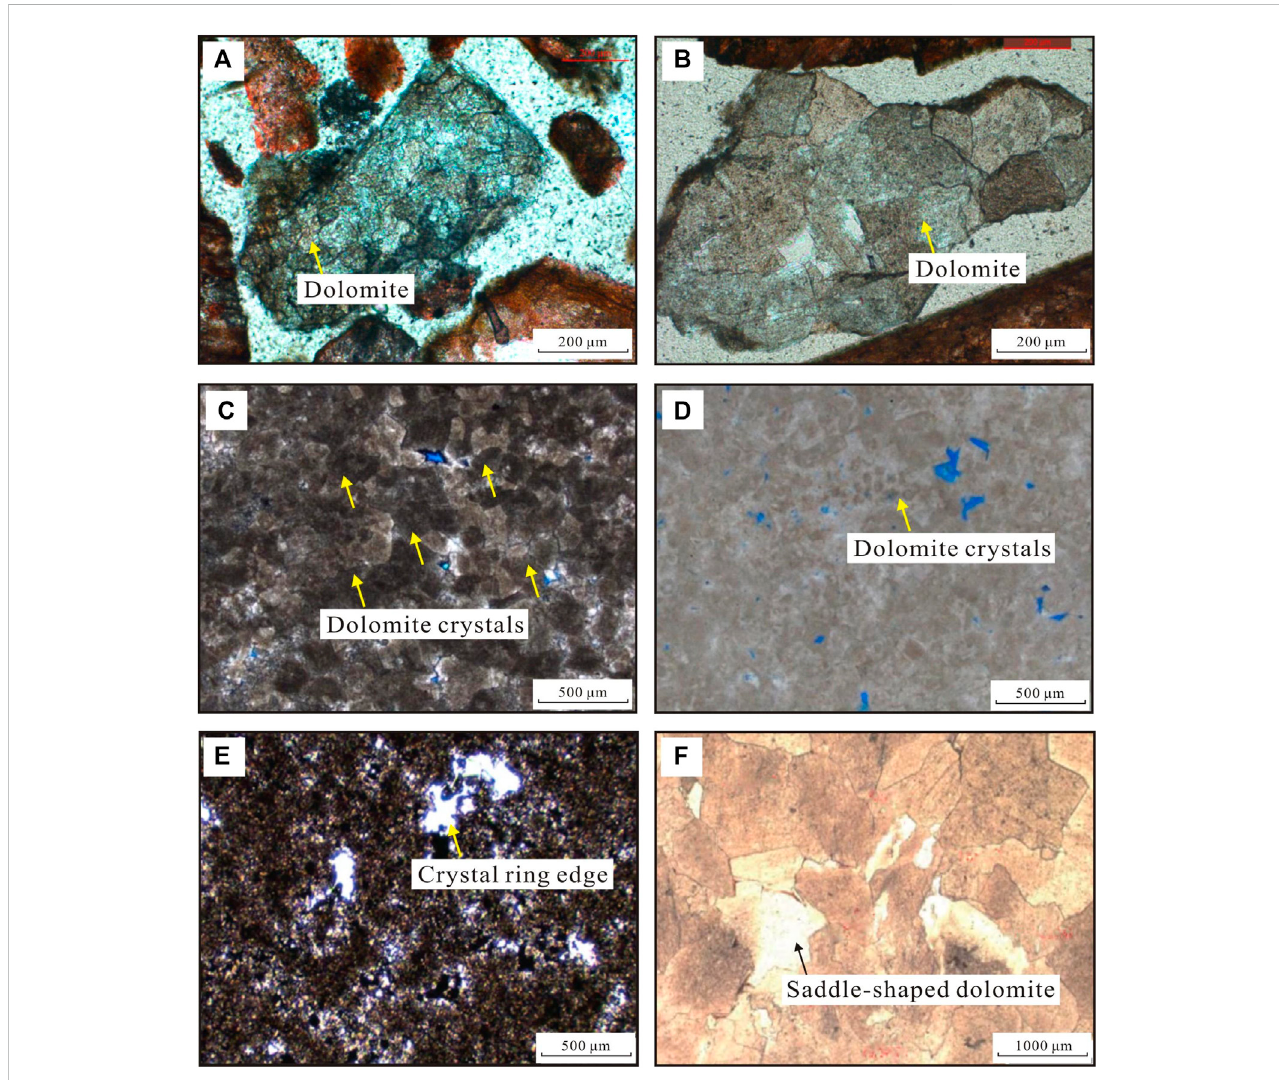
FIGURE 3 Microcosmic characteristics of dolomites of Permian Qixia Formation in central Sichuan Basin. (A) Moxi well 131X1, 4,291 m, mesocrystalline dolomite; (B) Gaoshi 128 well, 4,288 m, fi ne — medium crystalline dolomite; (C) Moxi 42 well, 4651.43 m, medium coarse crystal dolomite with blurred crystal edge; (D) Moxi 42 well, 4651.43 m, with obvious biodebris; (E) Heshen two well, mud-silty sand-clastic dolomite, 4357.5 m, with sparry ring edges on grain edges; (F) Gaoshi 16 well, saddle-shaped dolomite, 4556.4 m, coarse crystal, curved crystal surface and dissolution